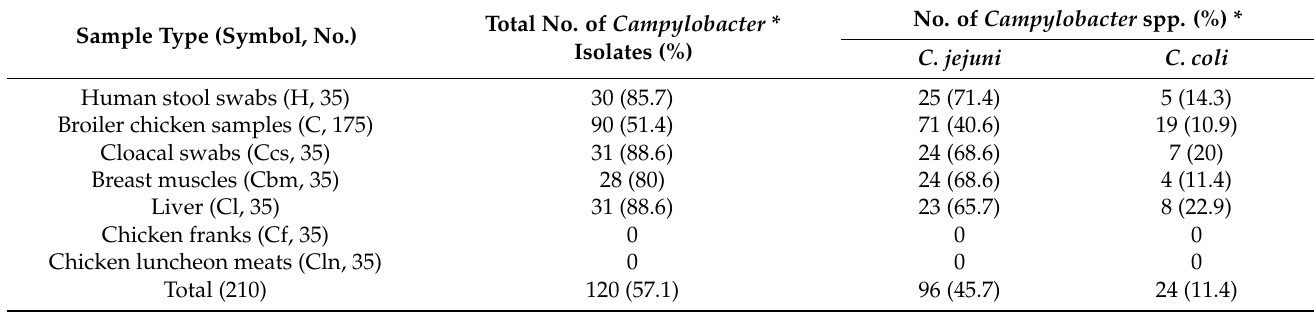
Table 1. Prevalence of Campylobacter species in different samples at Sharkia Governorate,